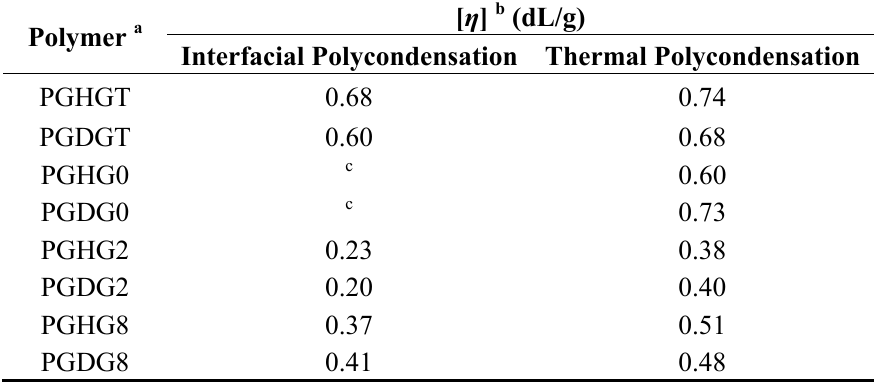
Table 2. Comparison between the intrinsic viscosities [ η ] of AABBP according to the polycondensation method (according to Ref. [234]).